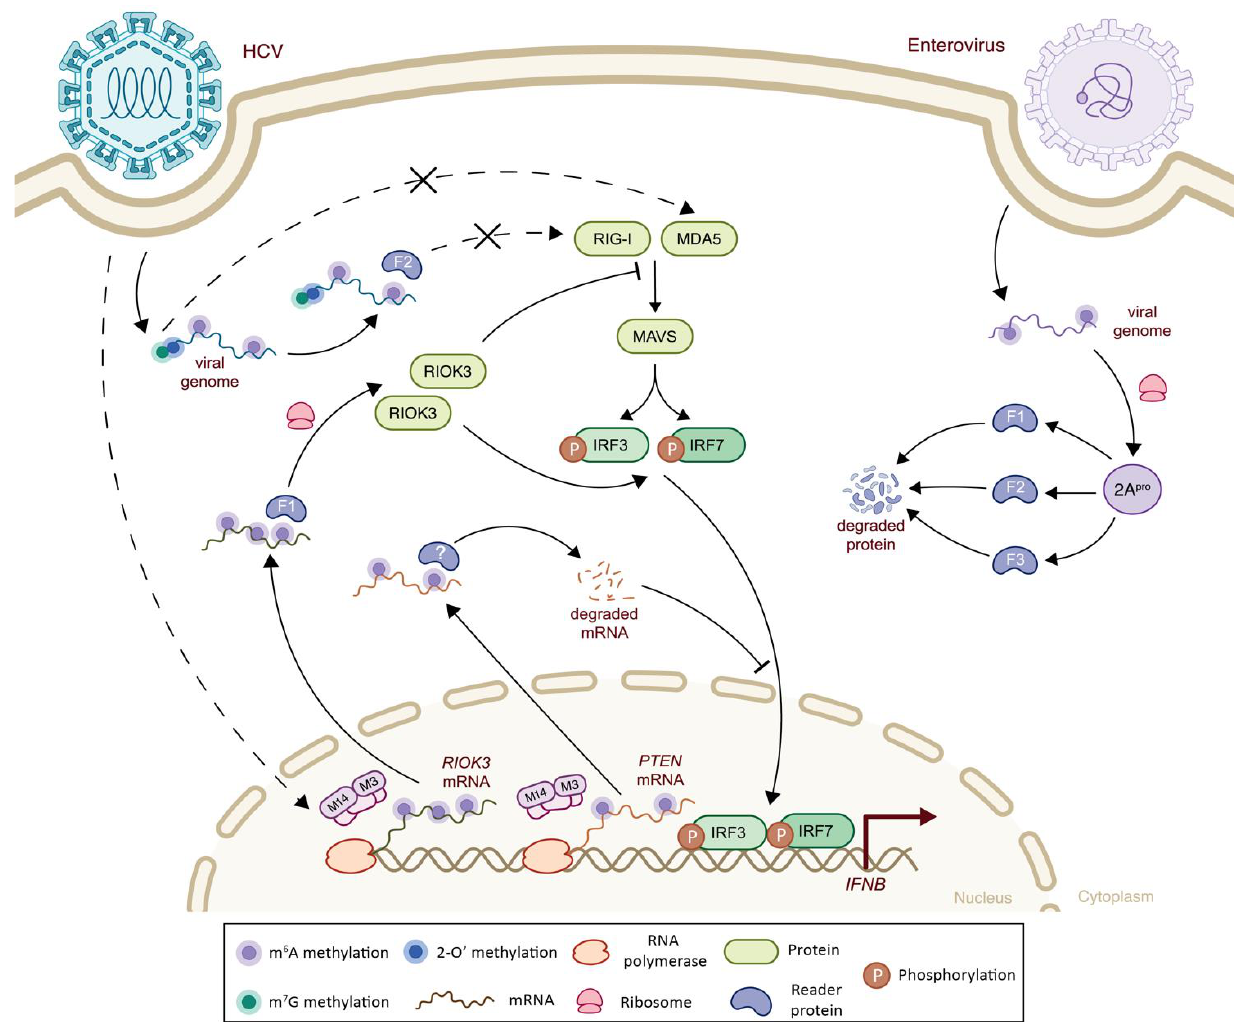
Figure 4. The impact of epitranscriptomic methylations on IFN-I response during HCV and En- terovirus infection. ( Left side ) Hepatitis C virus (HCV) genome carries a cap structure (m 7 G and 2 ′ -O methylations at its 5′ end, filled blue and green circles, respectively), added by its own methyl- transferase, NS5 (not shown), and is important to evade MDA5 sensing. M 6 A methylations (filled purple circles) of the HCV genome interact with the YTHDF2 (F2, light blue) protein and avoid RIG-I sensing. HCV infection also increases the m 6 A methylation levels of RIOK3 and PTEN transcripts. The increase in m 6 A methylations of RIOK3 increases its translation through YTHDF1 interaction and reduces HCV replication efficiency. RIOK3 has a dual effect on the RLR-mediated antiviral signaling pathway: it phosphorylates MDA5 or induces RIG-I and MDA5 degradation, thereby inhibiting their activation on one hand, and acting as an adaptor protein for IRF3 phosphorylation, thereby promoting further signaling on the other hand. On the contrary, the increase in m 6 A methylations of PTEN induces mRNA decay, and hence lowers PTEN protein levels, which results in lower IRF3 nuclear translocation. ( Right side ) M 6 A methylations also present in Enterovirus genome. In the early stages of infection, 2A pro viral protease cleaves YTHDF1-2-3 (F1, F2, and F3, respectively, light blue) reader proteins. The YTHDF3 protein has a positive regulatory effect on innate immunity by enhancing JAK/STAT signaling, and thus ISG production (not shown). F1: YTHDF1; F2: YTHDF2; F3: YTHDF3; M3: METTL3 ; M14: METTL14. Flaviviridae members, in addition to altering their own RNA, are able to affect host m 6 A methylations to evade cellular immunity. HCV, for example, has been identified